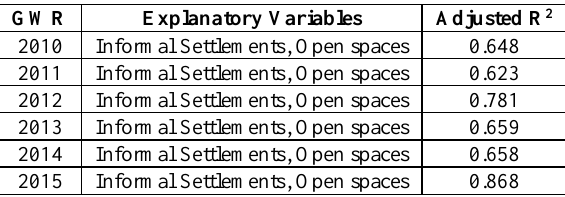
Table 6. Explanatories used for the GWR model of each year and their respective overall adjusted R 2